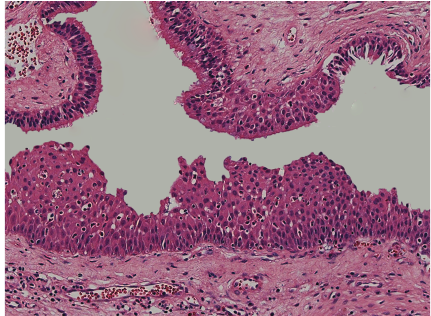
Figure 3: Pseudostratified ciliated epithelium of the Schneiderian mucosa with dysplastic areas (H.E—200x).